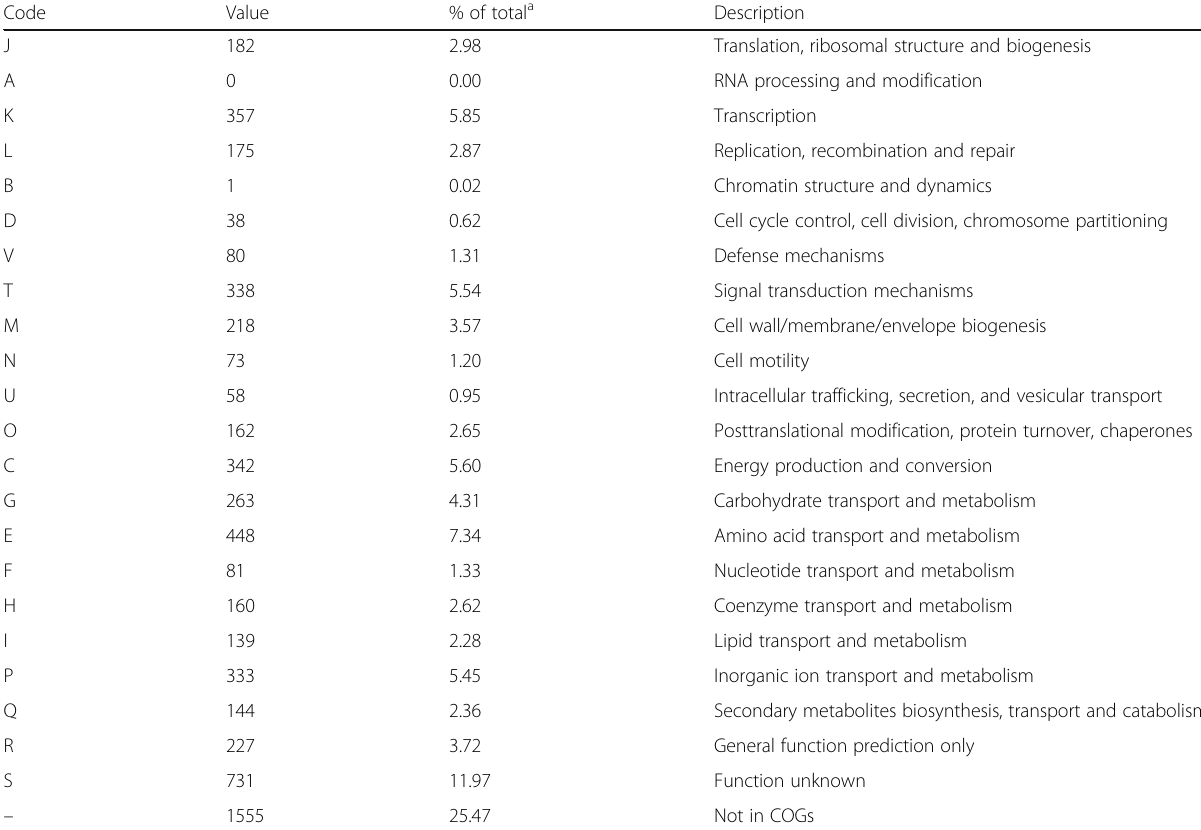
Table 5 Number of genes associated with general COG functional categories